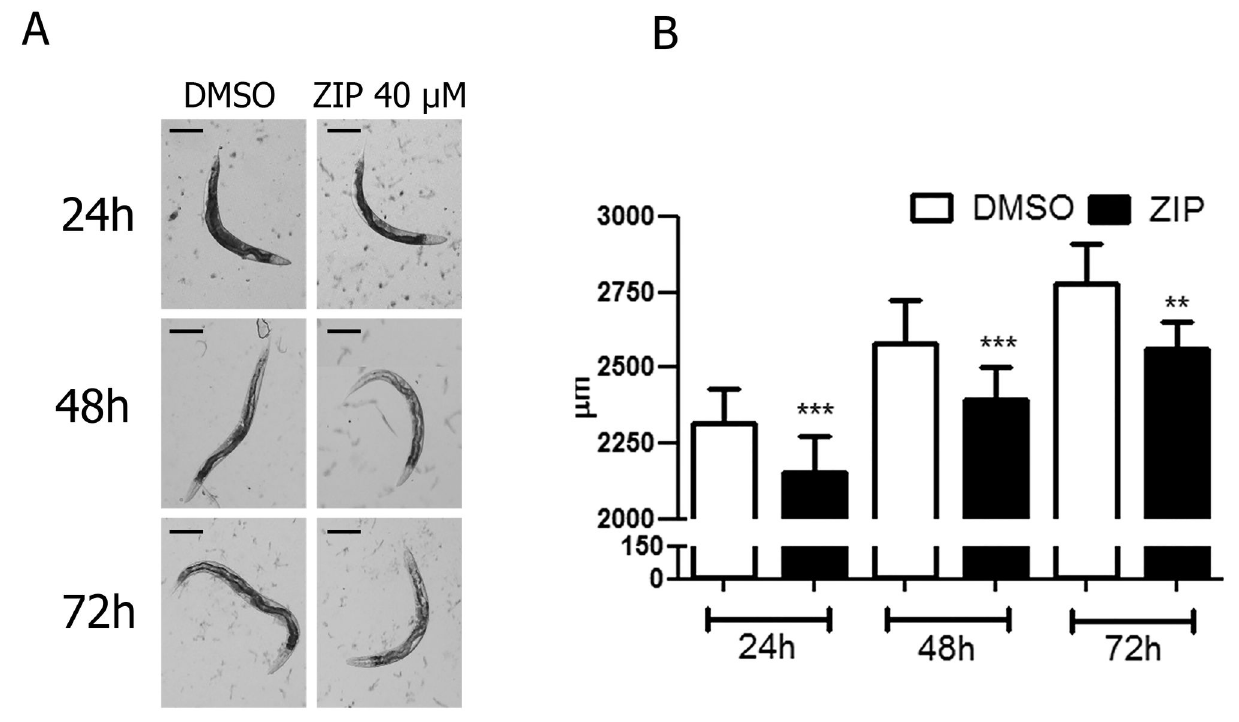
Figure 7. Caenorhabditis elegans wild-type (N2) perimeter after Ziprasidone treatment for 24, 48 and 72 hours. (A) Representative images of worms and (B) the perimeter quantification in µm after 24, 48 and 72 hours of Ziprasidone (40 µM) or vehicle control (DMSO 0.16% in Acetic acid (1:10 000)) exposition. After the determined times, the worms were removed of the plates and the images acquired with a stereoscope (40x, Nikon SMZ 1500 Stereoscope microscope). Statistically different compared to the respective control of each time (**p<0.001; ***p<0.0001, by Student’s T-test, mean, SD, n>20). The assays were confirmed